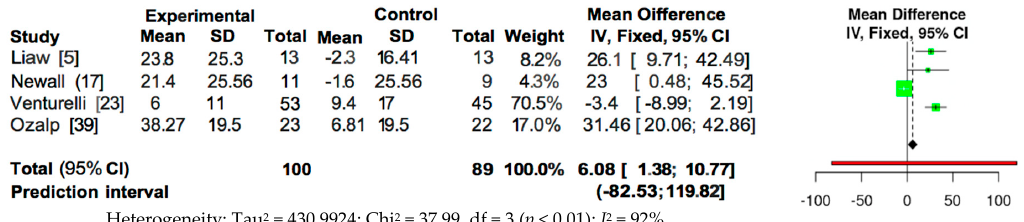
Figure 2. Forest plot for overall studies about PImax.